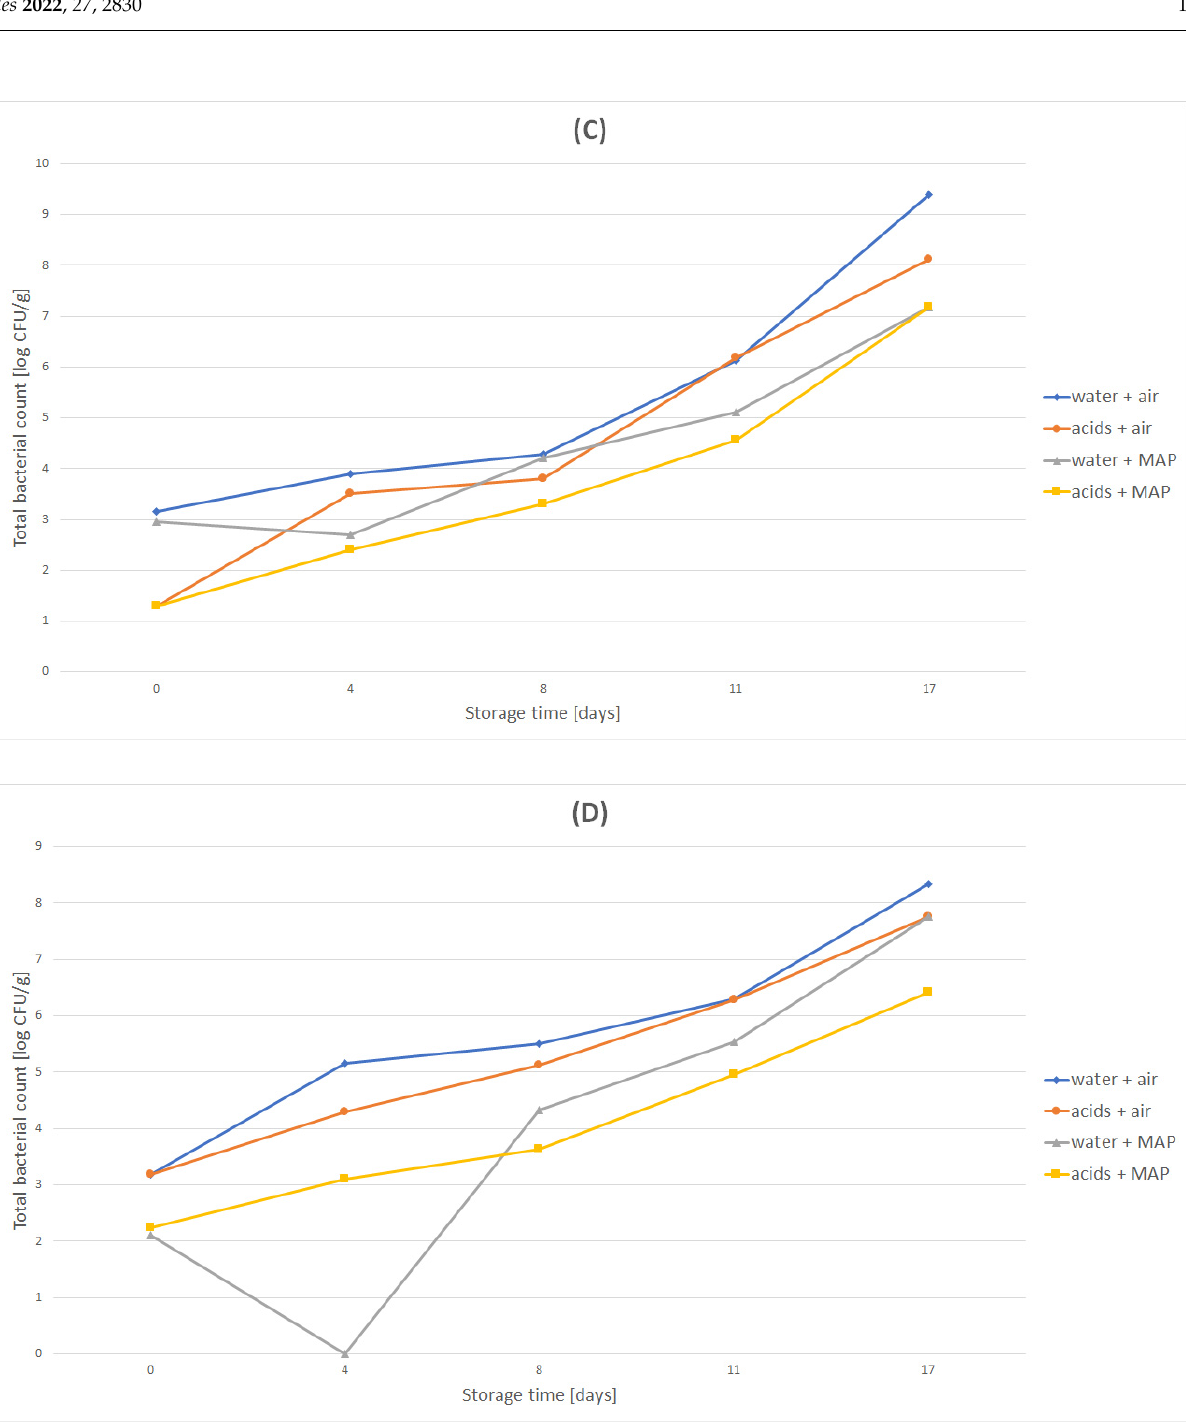
Figure 2. Microbiological quality of minimally processed carrots. ( A ) total number of microorgan- isms, ( B ) number of Enterobacteriaceae, ( C ) number of coliforms, ( D ) number of Pseudomonas.